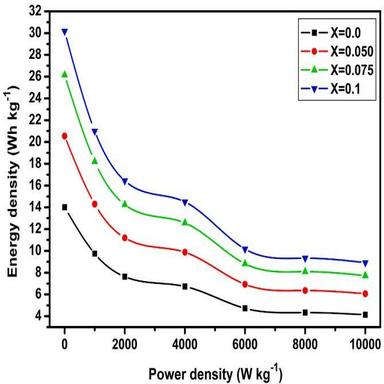
Energy density versus power density (Ragone plot) for CoFe2-xSmxO4 (x = 0.0, x = 0.050, x = 0.075 and x = 0.1) ferrites.